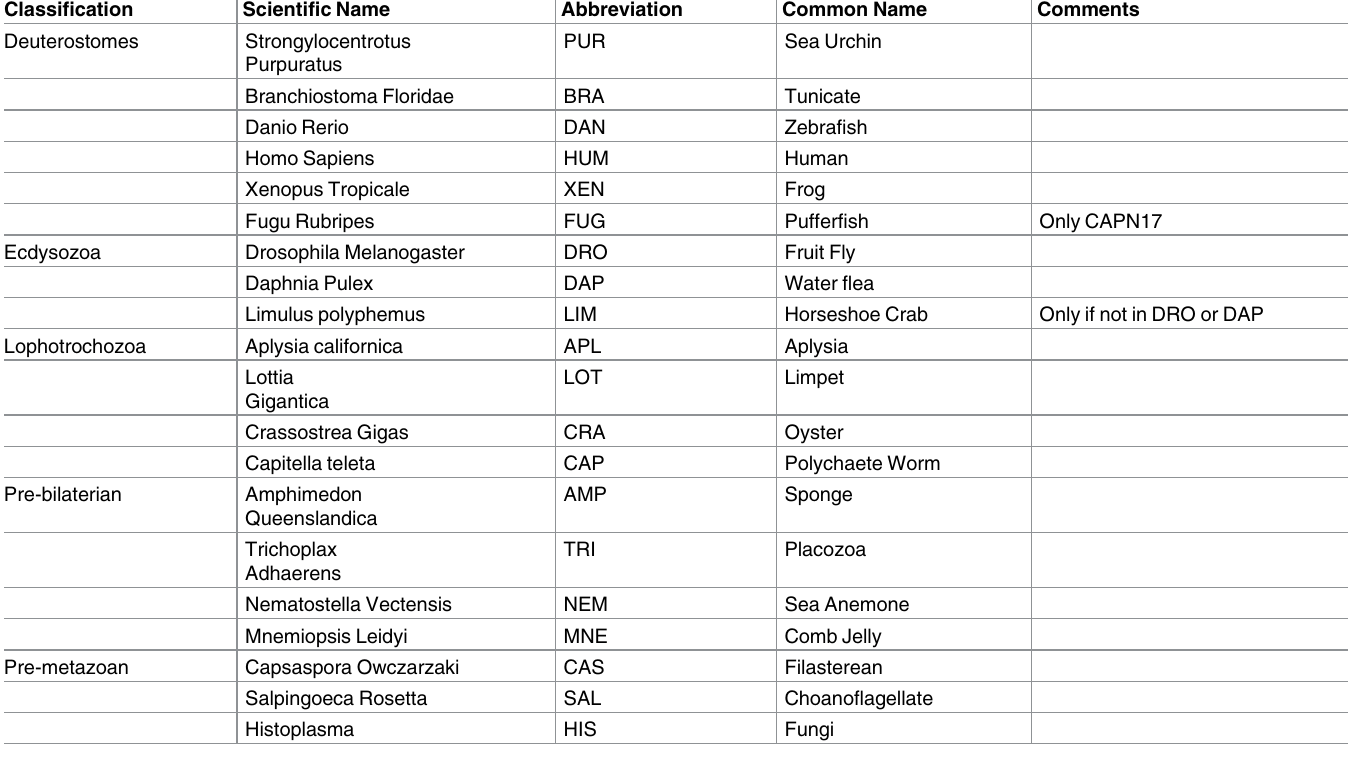
Table 1. Organisms used in Phylogenetic